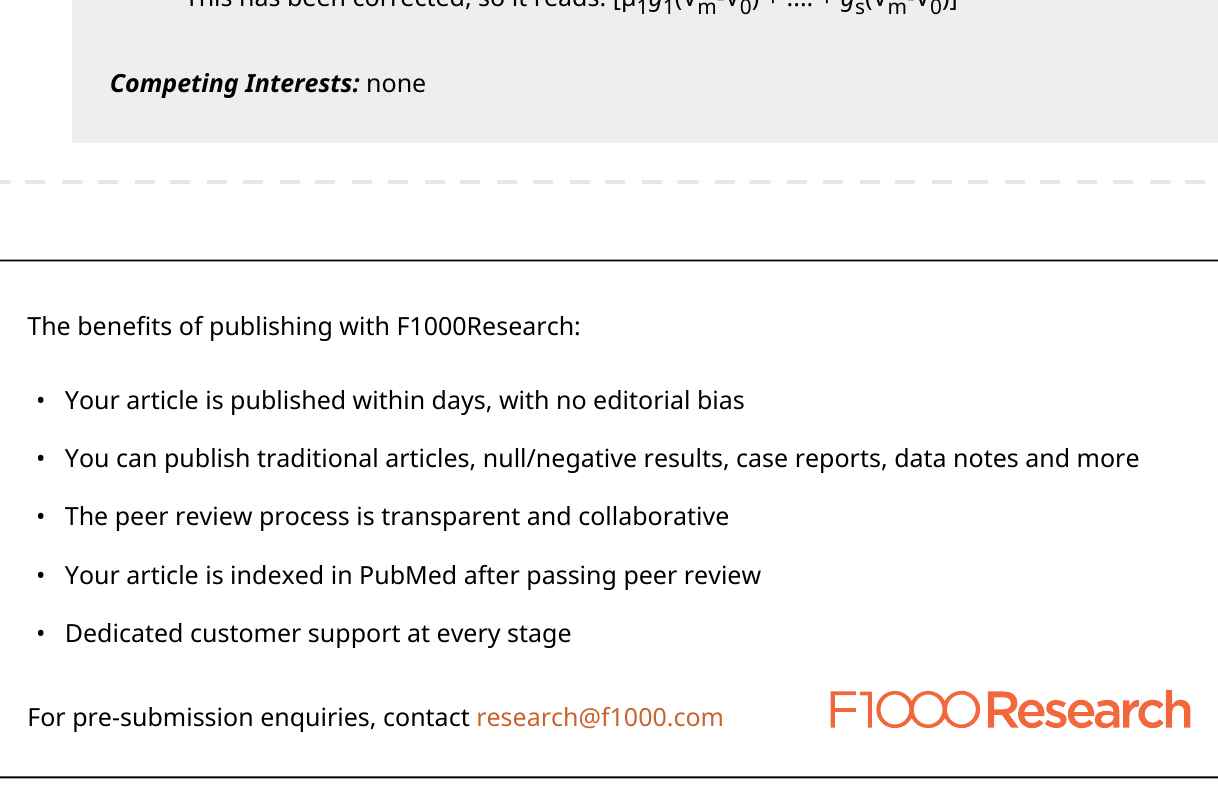
“Figure 7 and 8 are mixed up in the text and with their captions. Please re-arrange.” This was a mixup during publication, and has now been